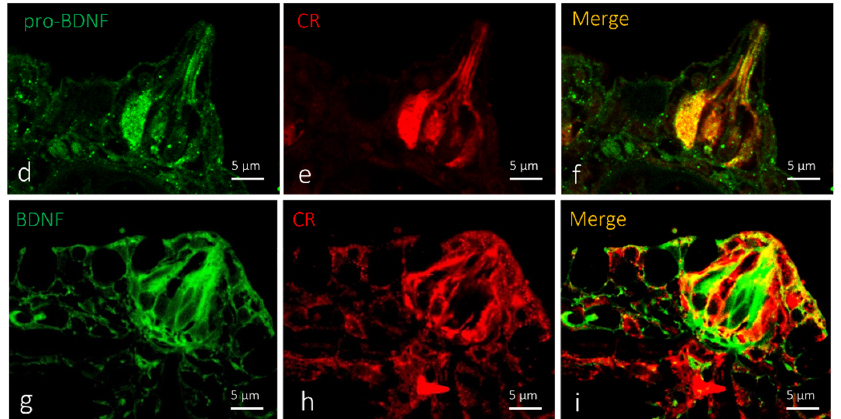
Figure 7. Oral taste buds: ( a – f ) zebrafish larvae (5 dpf); ( g – i ) adult zebrafish, transversal view. Immunohistochemical detection (immunofluorescence method) of ( a – f ) pro-BDNF and calretinin and ( g – i ) BDNF and dalretinin. Subpopulation of sensory cells that might be identified as light cells showing immunopositivity to ( a , d ) pro-BDNF and ( b , e ) calretinin. ( g ) BDNF in light sensory cells and ( h ) calretinin in dark sensory cells. ( c , f , i ) Colocalization view. Scale bar, 5 µm. The observed ICCCs are spindle-shaped and resemble taste-bud sensory cells, plentifully equipping the skin of the zebrafish lips. The ICCC shape closely resembles that